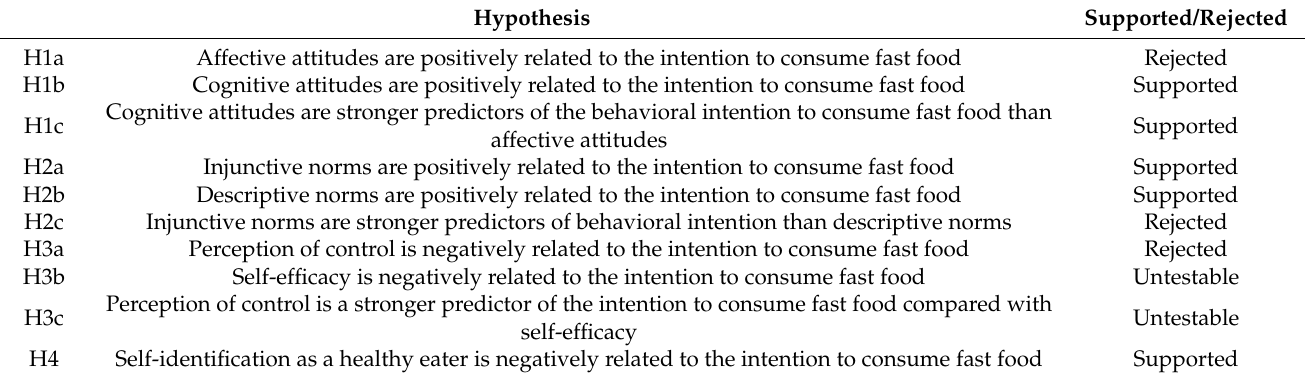
Table 5. Summary of hypothesis